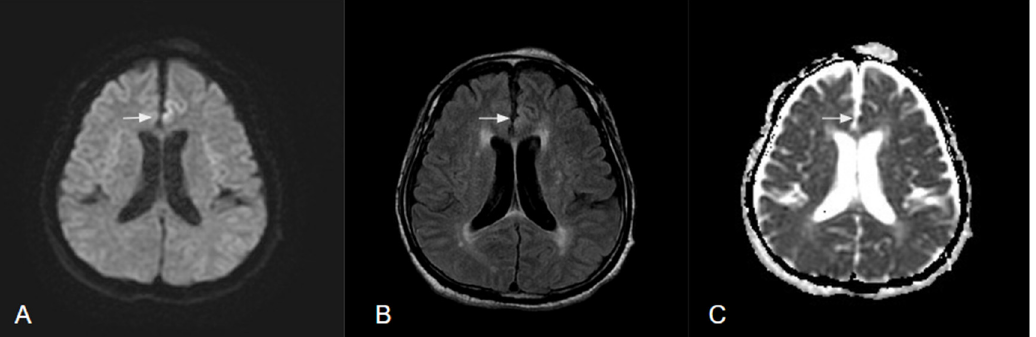
Figure 2. MR images of brain in a patient with status epilepticus. ( A ) Hyperintensity of DWI in cortical area and hypointensity in subcortical area. ( B ) Hyperintensity in T2 FLAIR at same region. ( C ) Hypointensity of ADC in cortical region.